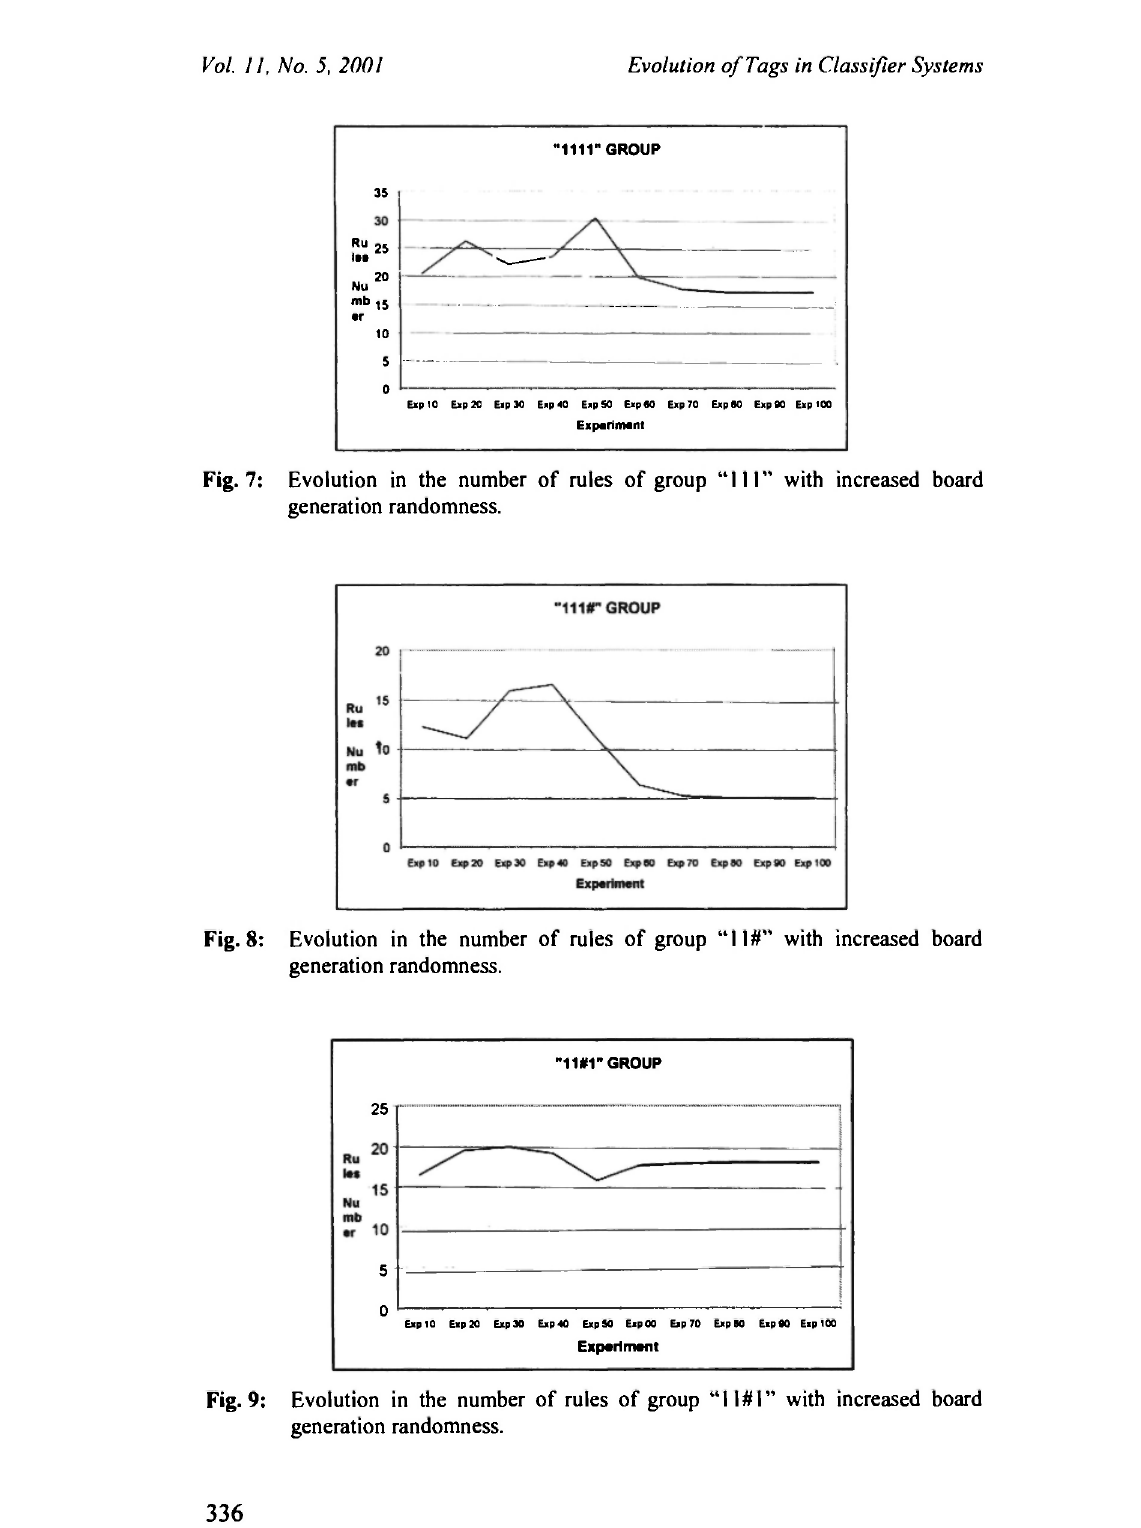
Fig. 7: Evolution in the number of rules of group "111" with increased board generation randomness.